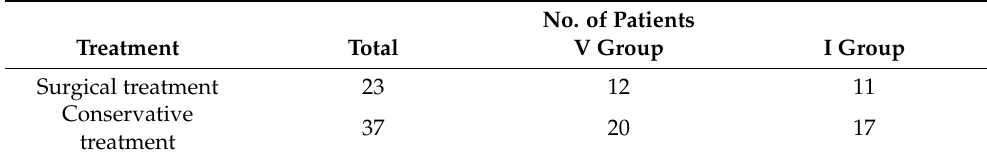
Table 3. Treatment for patients ( n =